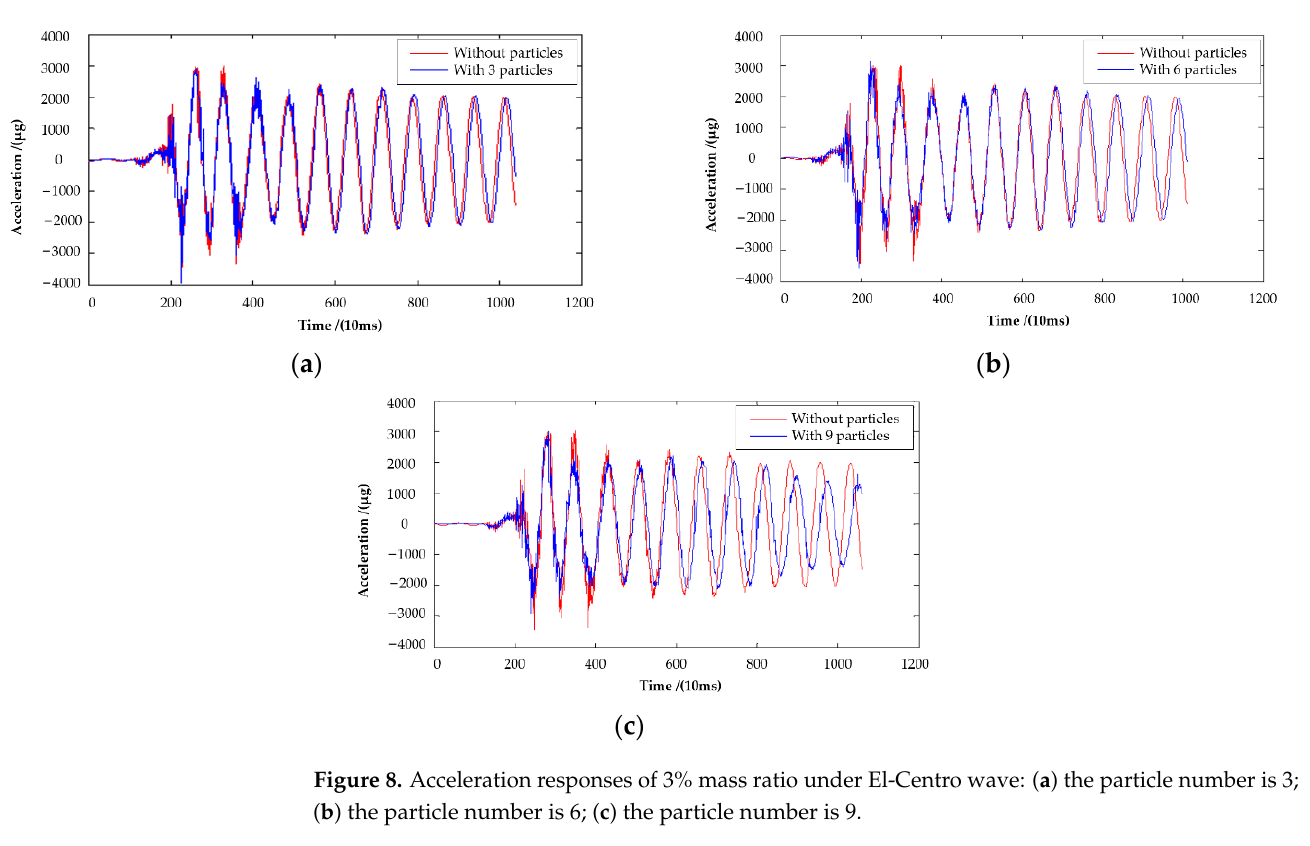
the particle number is 6; ( c ) the particle number is 9.